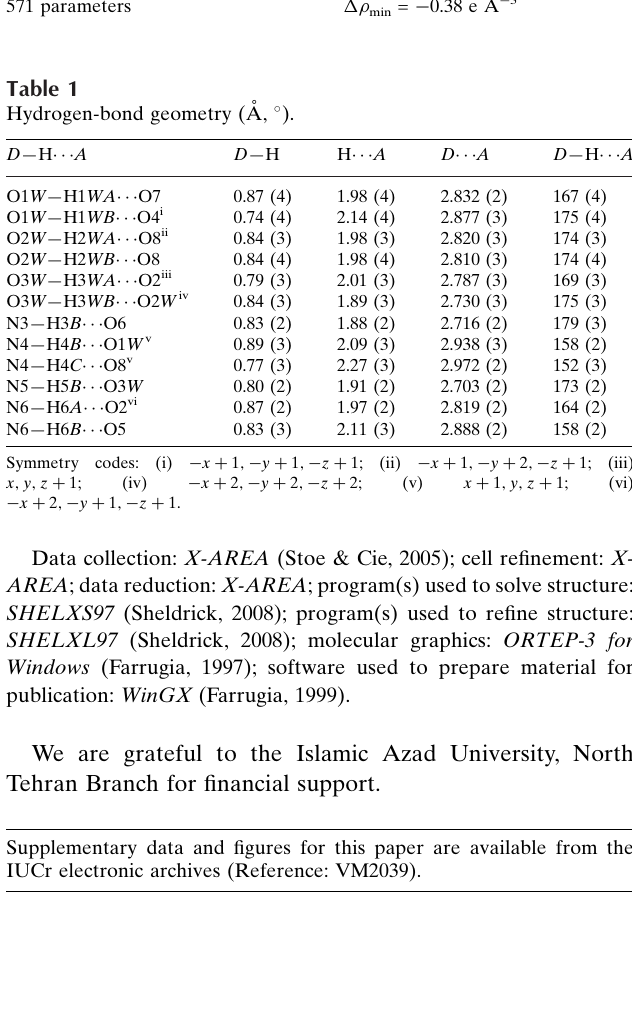
Data collection STOE IPDS II diffractometer Absorption correction: numerical [shape of crystal determined optically ( X-RED32 and